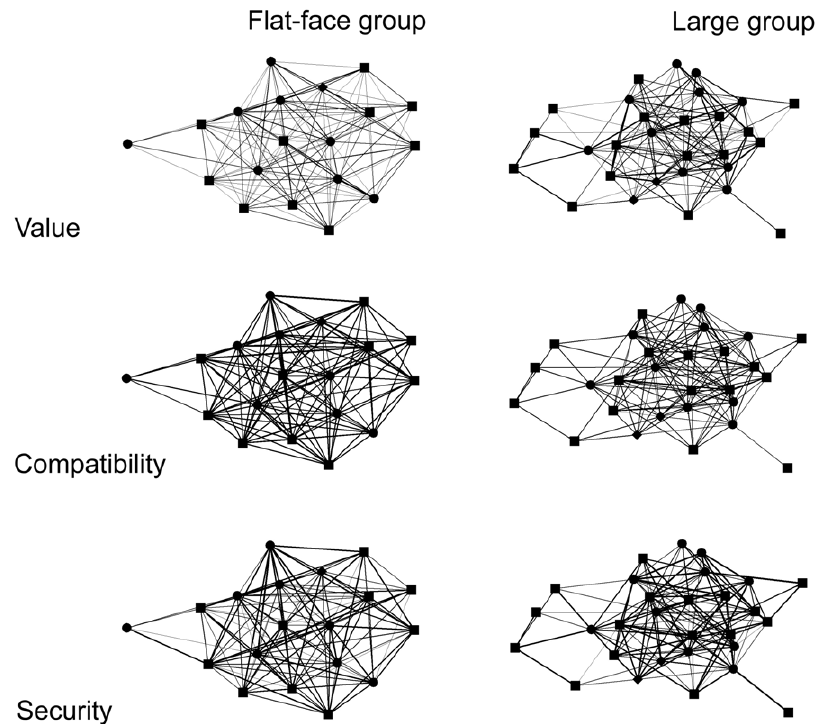
Figure 1. Social network graphs of the two study groups. Nodes represent individual group members (circles=adult females, squares=adult males, diamonds=sub-adult males). The thickness of the inter-connecting lines represents the tie-strength of principal component scores (i.e. value, compatibility and security) shared between dyads.